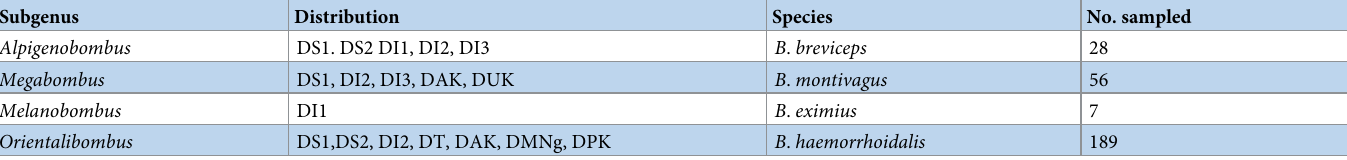
Table 3. A list of Bombus subgenera with information on distribution and species number. Subgenus Distribution Species No.